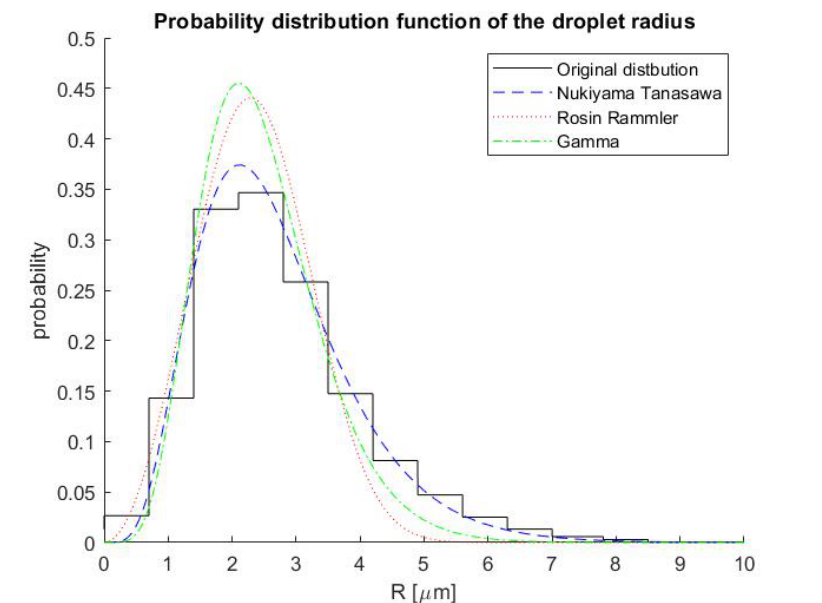
Figure 1. Normalized experimental probability distributions and various approximations by proba- bility density functions (Nukiyama–Tanasawa, Rosin—Rammler, and gamma distributions) of the droplets’